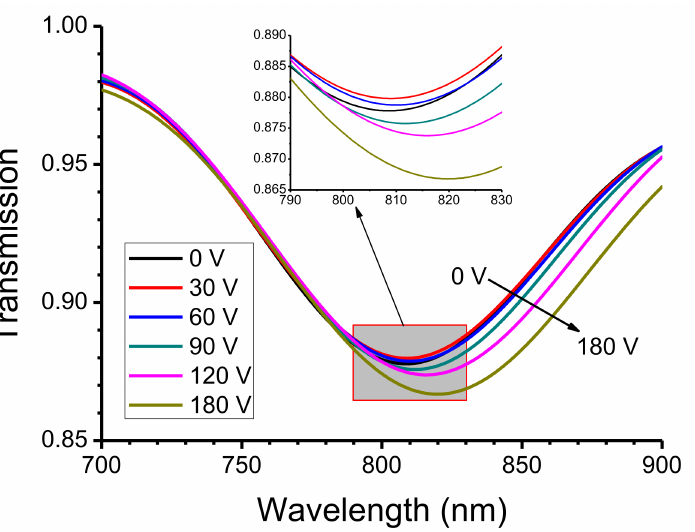
Figure 2. The transmission spectra for 1% bovine serum albumin (BSA) solution for external voltages from 0 to 180 V.